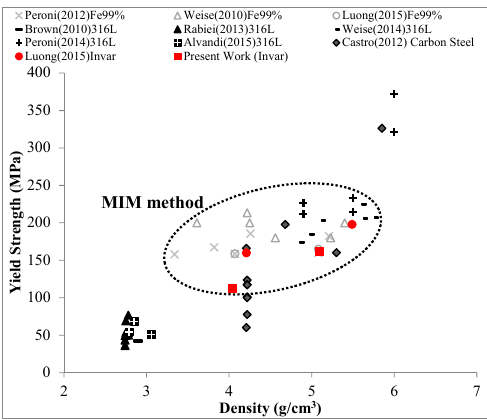
Figure 8. The yield strength of Invar SFs ‐ filled cenospheres in comparison to other steel based matrix SFs. The data is generated and collected from references [13,14,17,20–22,28–31].